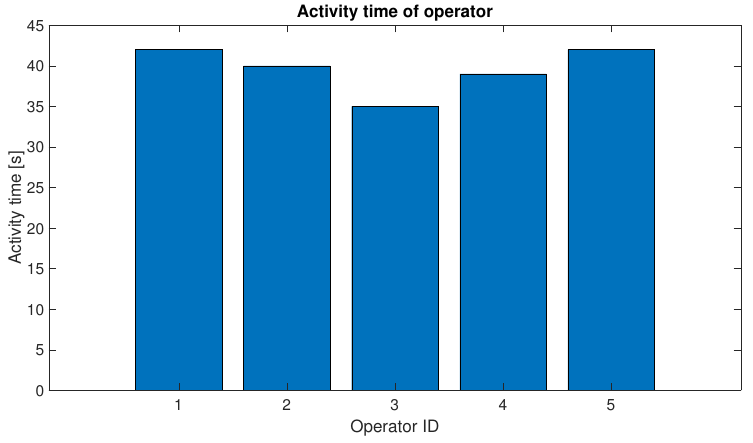
Figure 9. Comparison of the operators’ activity